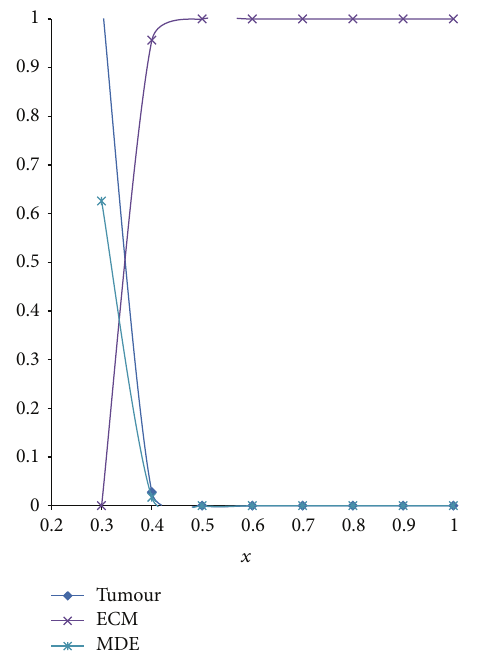
Figure 6: One-dimensional MDM and HPM solution of the system (3)–(5) with constant tumour cell diffusion showing the cell density, MDE concentration, and ECM density at 𝑡 = 10 .